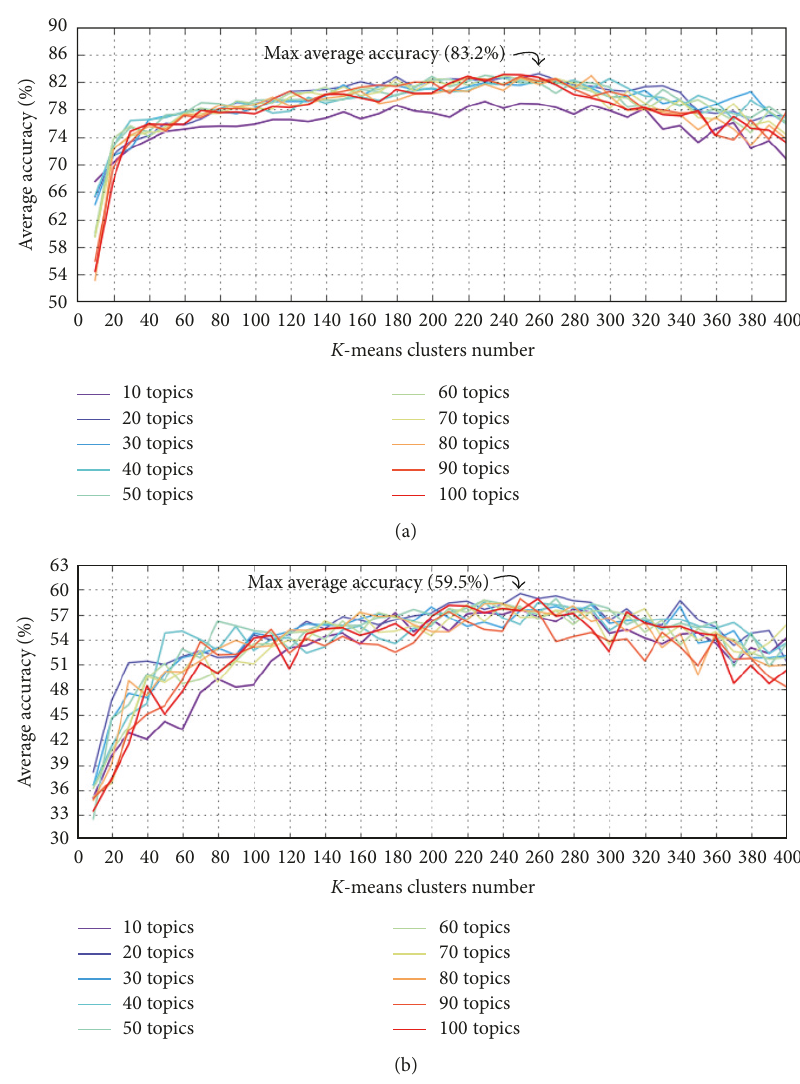
Figure 12: Average accuracy of (a) FrameDiff GridIntersect Kmeans and (b) MultiCue GridIntersect Kmeans , with 𝐾 ranging from 10 to 100 and 𝑐 ranging from 10 to